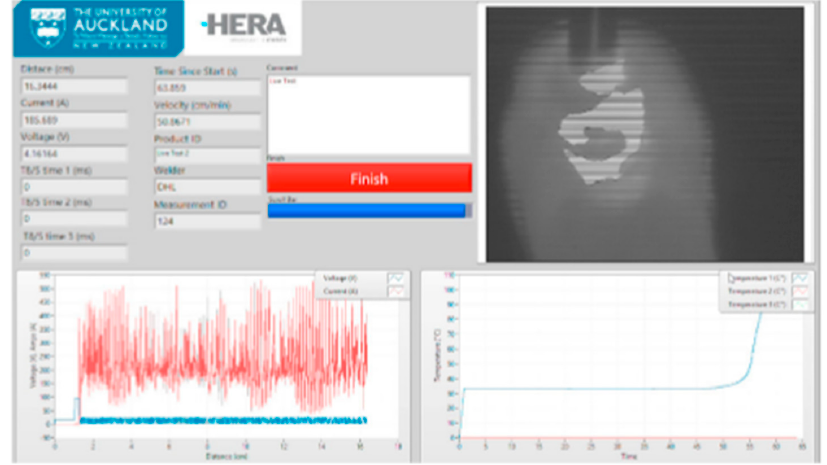
Figure 9. The interface features of the front panel view ( reprinted with permission from [116] 2020 © the author(s)).